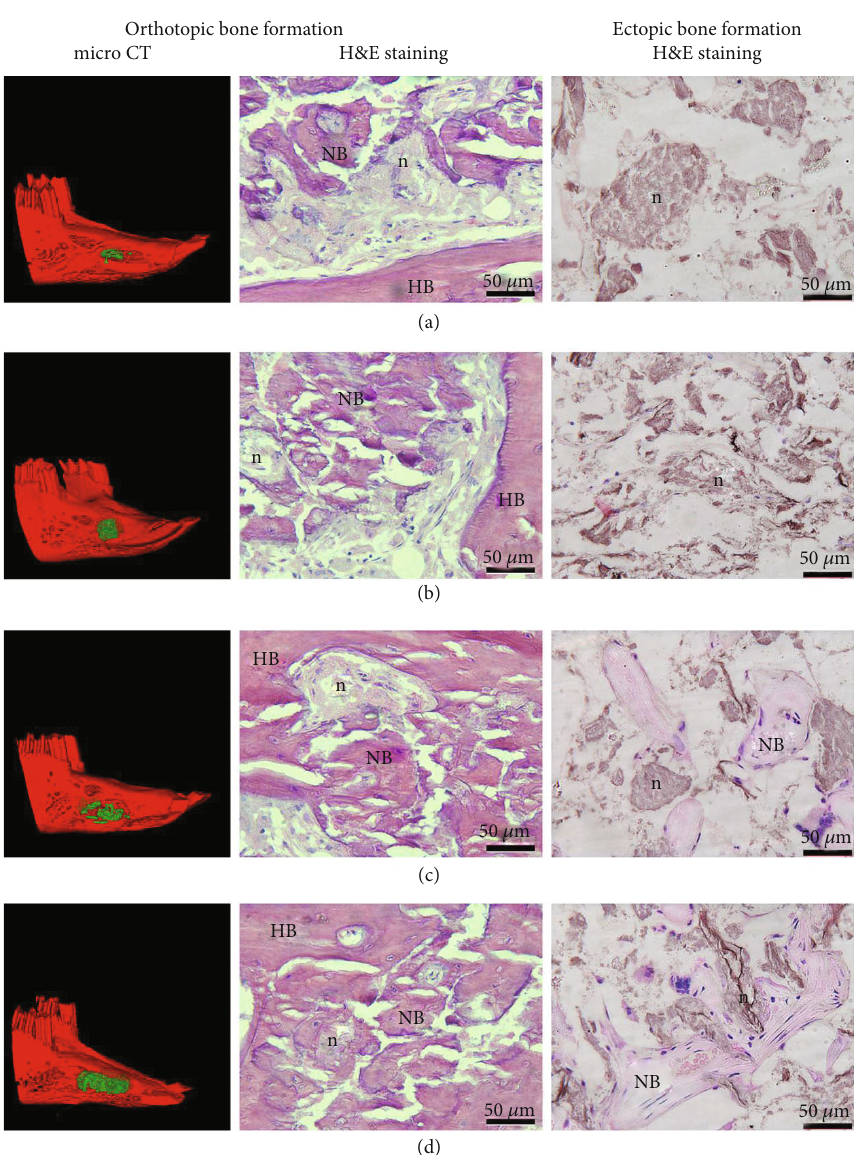
Figure 9: Assessment of engineered bone formation in the in vivo ectopic and orthotopic microenvironment after 3 months of surgery. (a) nHAC/PLA. (b) hUC-MSCs+nHAC/PLA. (c) hUC-MSCs+nHAC/PLA+OMD. (d) hUC-MSCs+nHAC/PLA+OMD+rhBMP-7. Scale bar = 50 μ m . Green indicated newly formed bone in micro-CT image. HB: host bone; NB: new bone; n: